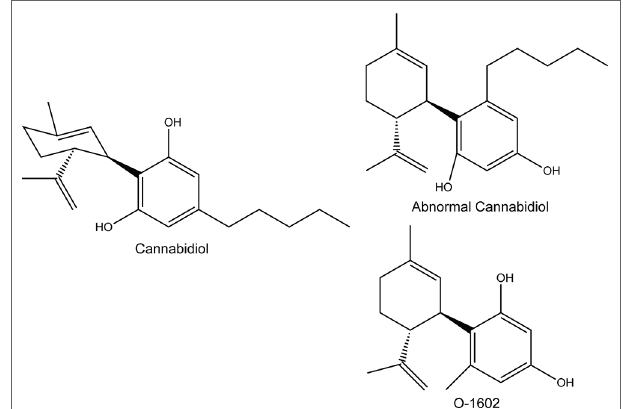
FIGURE 1 | Structure of the compounds used in this study; O-1602 and abnormal cannabidiol, compared to